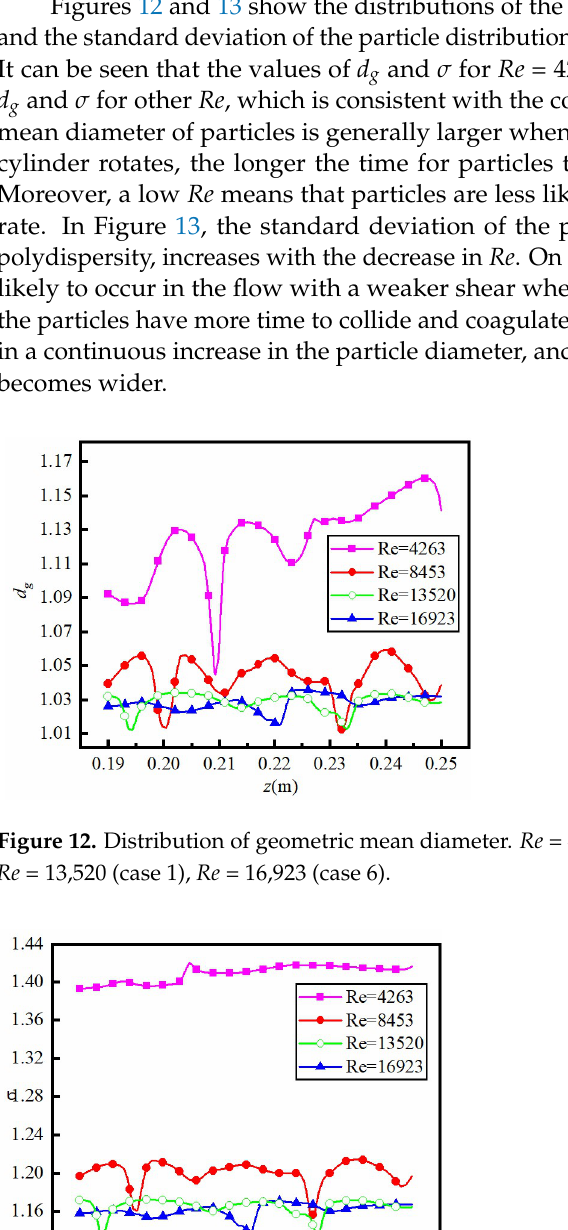
Figure 11. Axial distribution of M 0 in the middle position of the inner and outer cylinders. Re = 4363 (case 4 in Table 1), Re = 8453 (case 5), Re = 13,520 (case 1), Re = 16,923 (case 6).